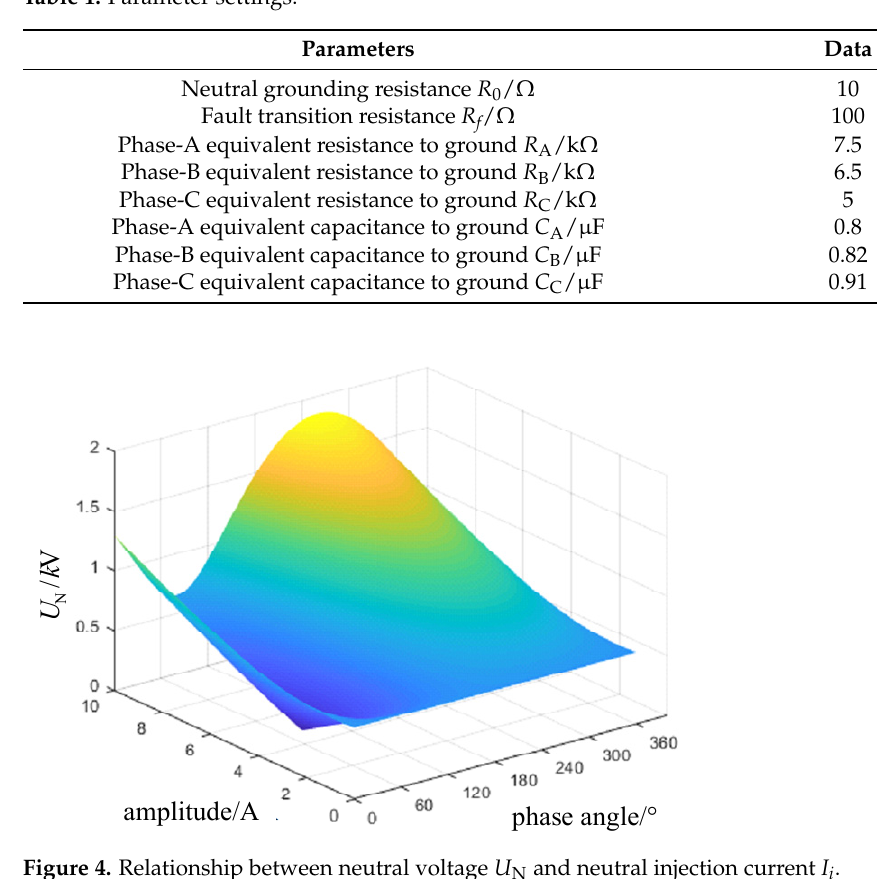
Figure 4. Relationship between neutral voltage U N and neutral injection current I i.